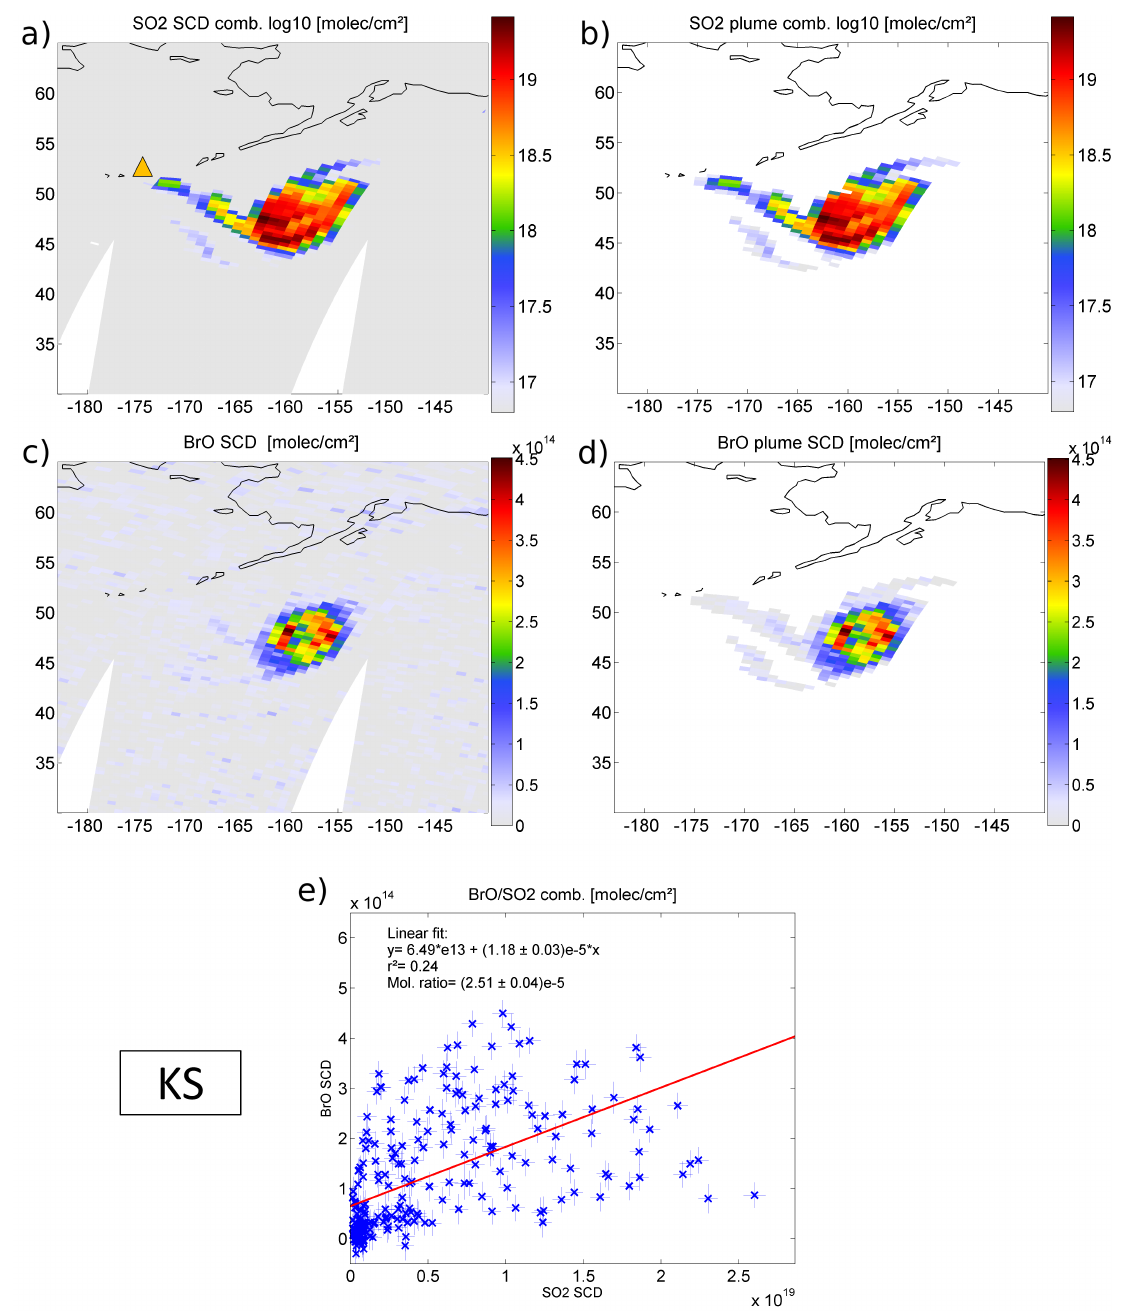
Fig. 11. SO 2 and BrO SCDs during the second day of the Kasatochi eruption (9 August 2008). While the SO 2 plume ( a and b ) and the enhanced BrO ( c and d ) are in principle located at the same area, the spatial distribution for BrO appears more circular than for the SO 2 . The correlation plot (e) shows a positive correlation between the species ( r 2 =0.24), but also a large scatter in the BrO SCDs ∗ with increasing SO 2 SCDs ∗